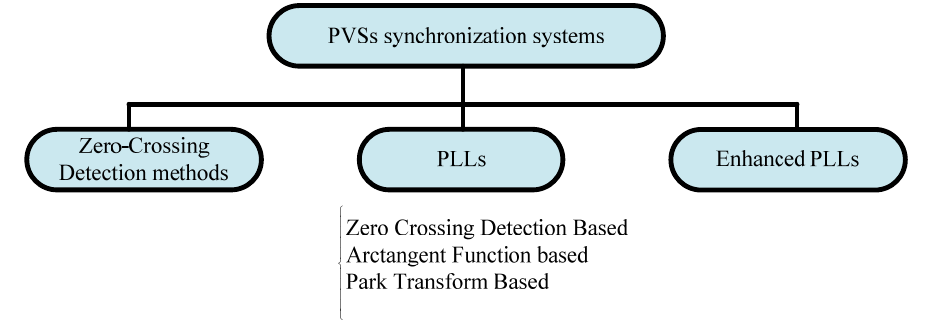
Figure 2. PVSs synchronization techniques classification.